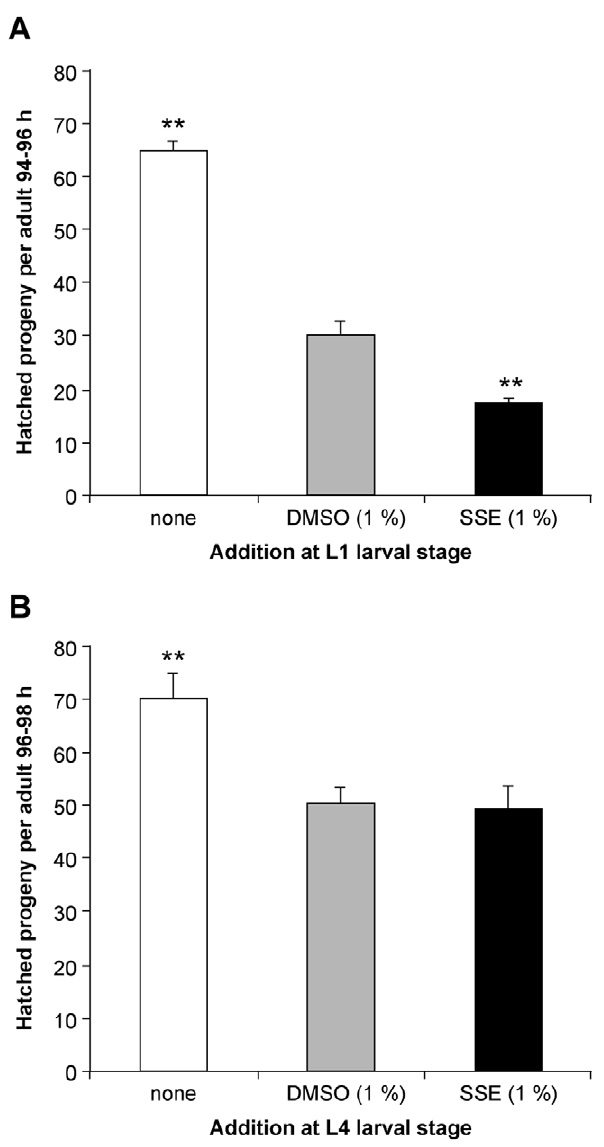
Figure 4. Number of hatched progeny is affected following SSE and DMSO exposure. Hatched progeny from 94–98 h post-hatch adults counted microscopically and expressed per adult. Error bars depict SEM n=23 representing individual replicate counts from 4 independent experiments. (A) Exposure from L1 larval stage. (B) Exposure from L4 larval stage. ** p ,